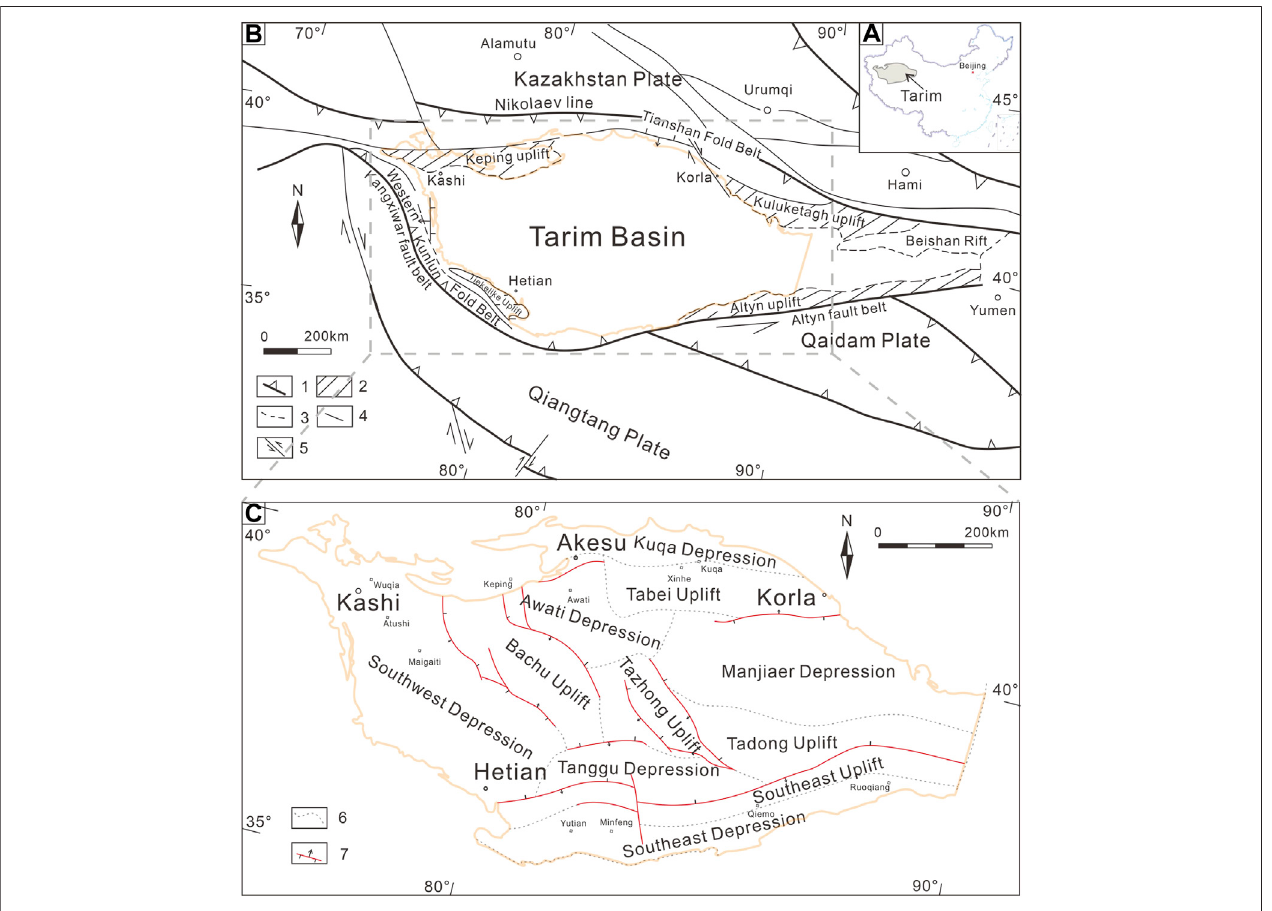
FIGURE 1 | (A) Location of the Tarim Basin; (B) Simpli fi ed tectonic map of Western China showing the major plate tectonic setting (modi fi ed from Yu et al., 2016); (C) Tectonic units of the Tarim Basin. 1. Plate sutures; 2. Uplift; 3. Thrust fault belt; 4. Major fault; 5. Strike slip fault; 6. Tectonic unit boundary; and 7. Reverse fault.